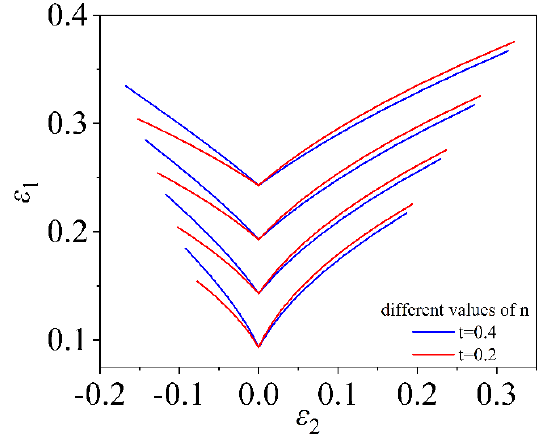
Figure 15. FLD for different values of n at t = 0.0 and 0.4. The coefficient of normal anisotropy r reflects the difference between the plane di- rection and the thickness direction of the sheet during the deformation process. After considering the induced stress in the thickness direction, the effect of the r on the FLD has changed significantly.